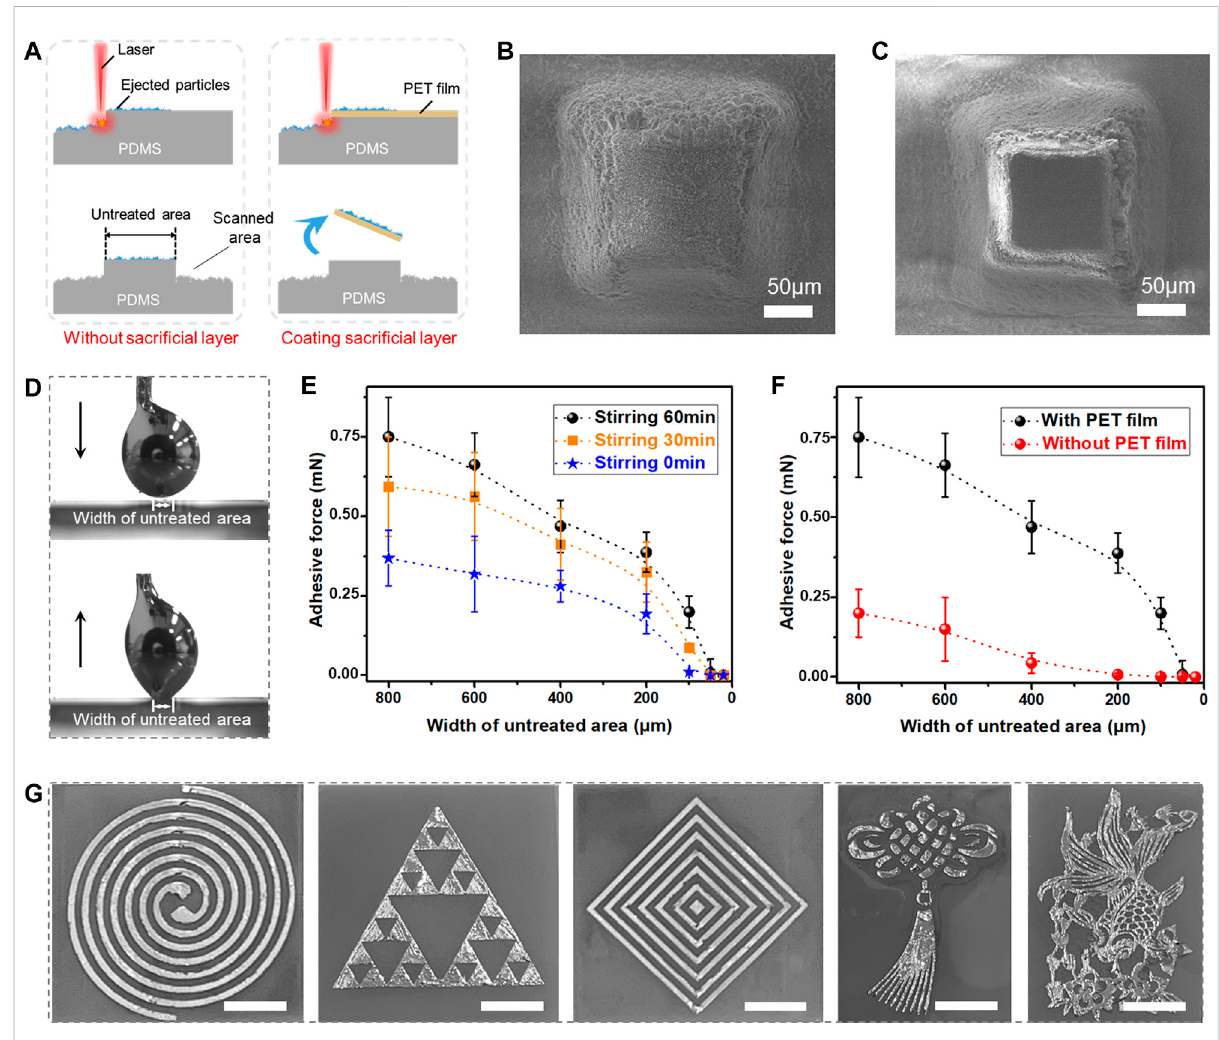
FIGURE 4 In fl uence ofsacri fi ciallayer onliquid metal printing. (A) Usage ofthesacri fi cial layerto remove theablationparticleson anun-scannedarea. (B) SEM image of the untreated square pattern on PDMS surface without sacri fi cial layer. (C) SEM image of the untreated square pattern using sacri fi cial layer method. (D) Process of a liquid metal droplet contacting with and then leaving from the untreated square pattern on PDMS surface with differentwidths. (E,F) Relationshipbetweenadhesiveforceandwidthofuntreatedareawith (E) differentstirringtimesand (F) differentsacri fi cial layer treatments. (G) Optical images of LM patterns on PDMS surfaces with high resolution, such as spiral, triangular array, diamond array, Chinese knot, and gold fi sh. Scale bar: 5